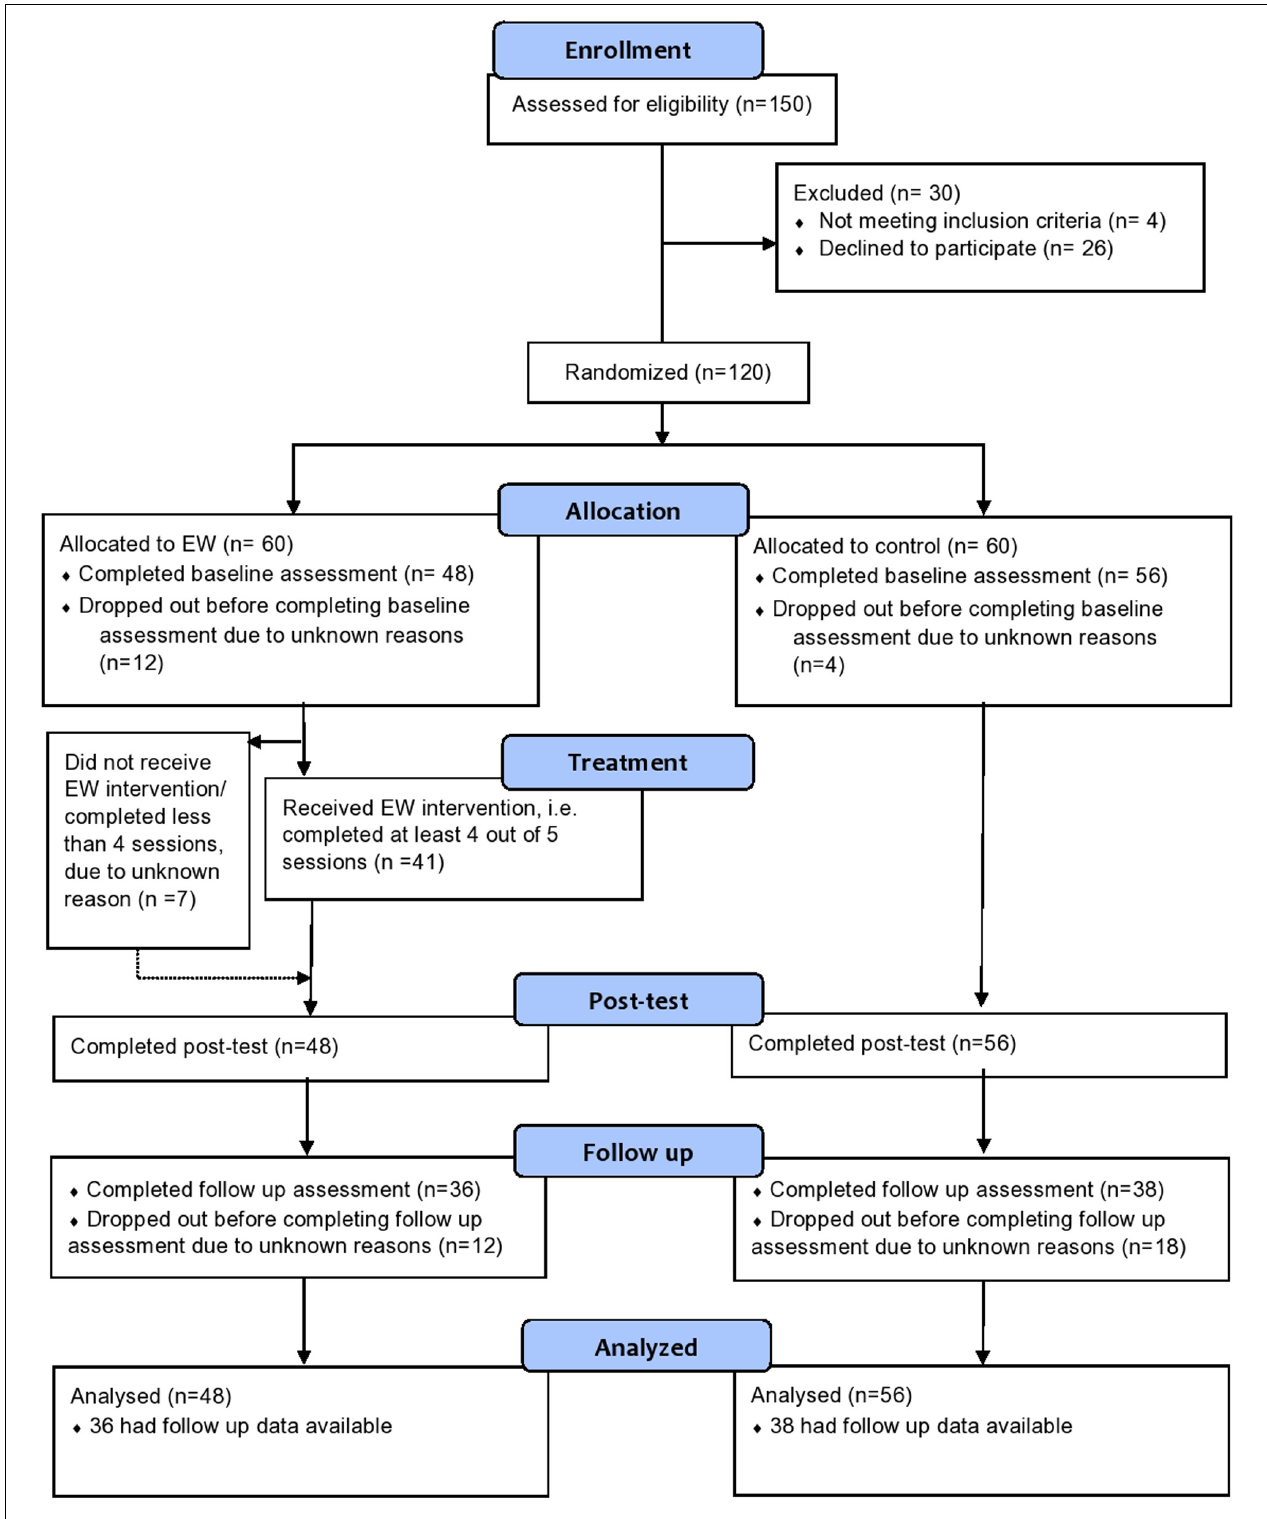
FIGURE 1 | Trial flow